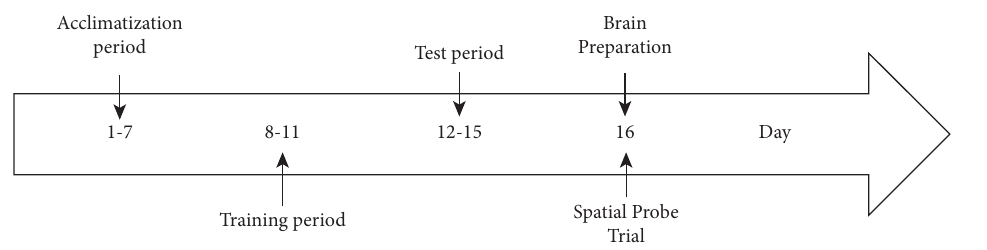
Figure 1: A general overview of the animal study